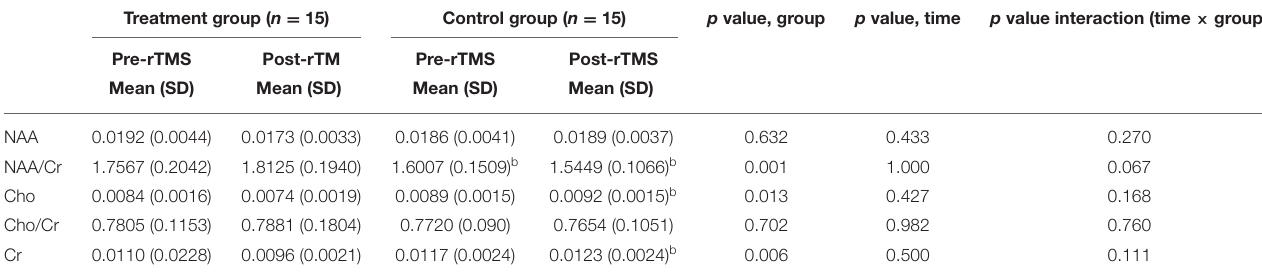
TABLE 5 | Comparisons of neurotransmitters in the left DLPFC by MRS between pre- and post-rTMS treatment of the two groups. Treatment group ( n =